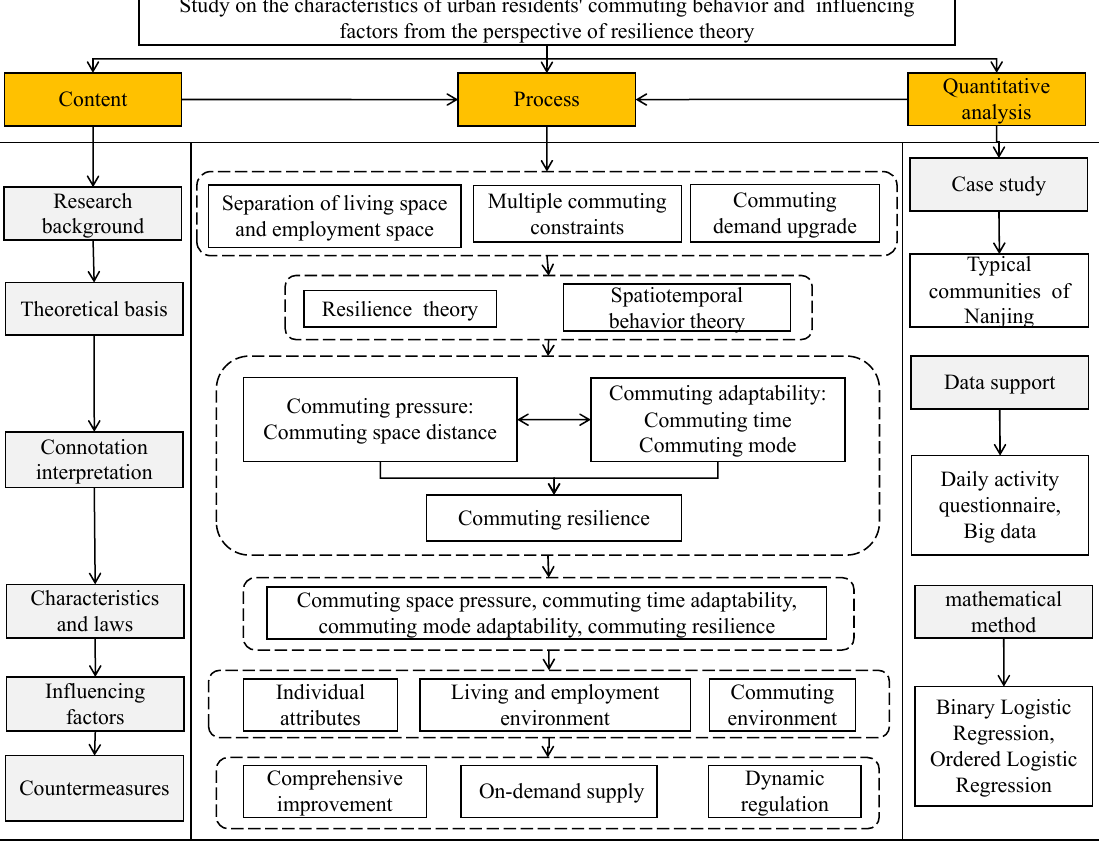
Figure 2. An analytical framework of urban residents’ commuting behavior characteristics and influencing factors from the perspective of resilience theory. Table 3. The judgment matrix of commuting characteristics from the perspective of resilience